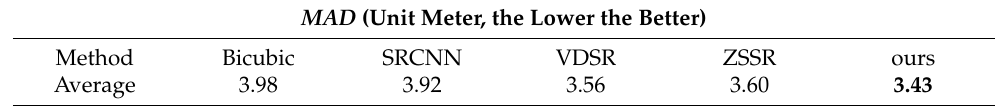
Table 4. MAD for the test